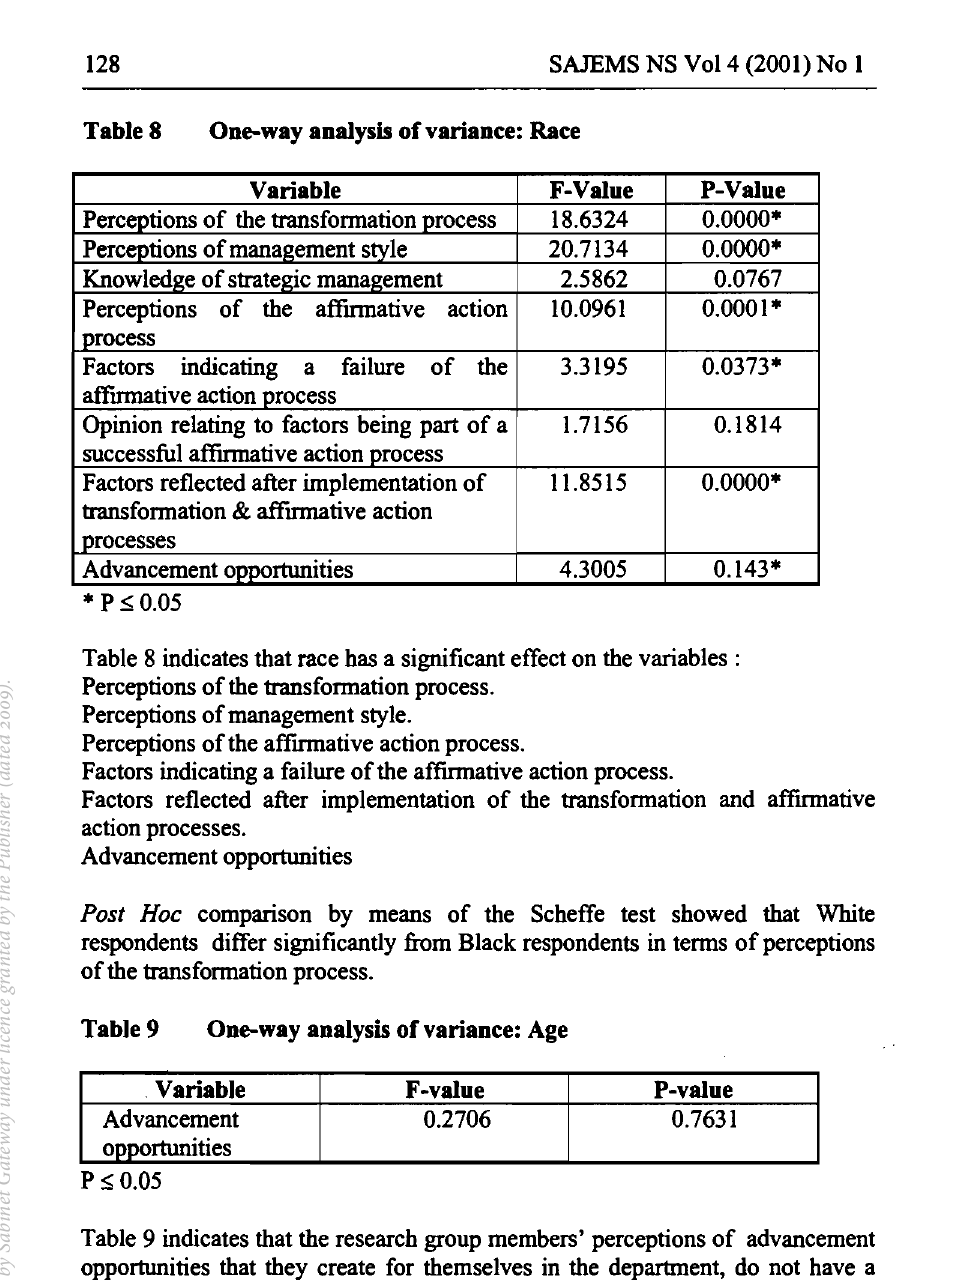
One-way analysis of variance: